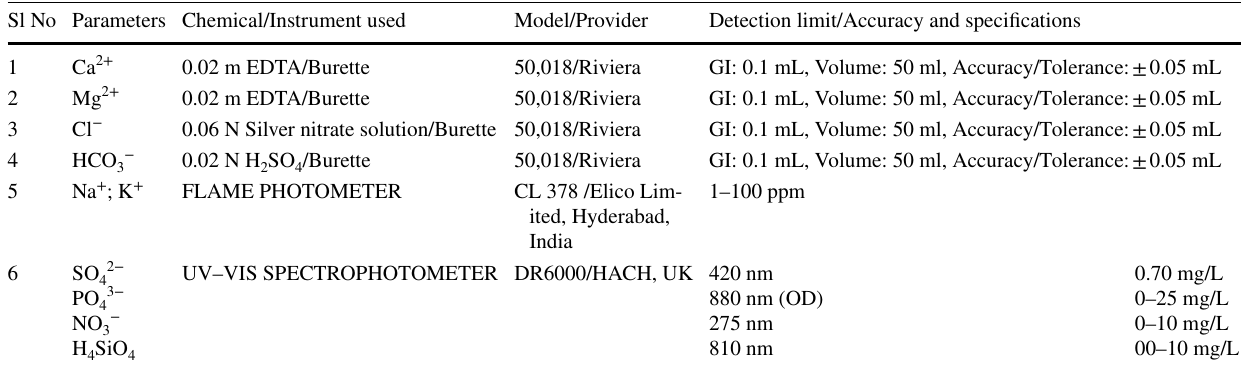
Table 1 Analysing instruments and their specifications of hydrochemical parameters Sl No Parameters Chemical/Instrument